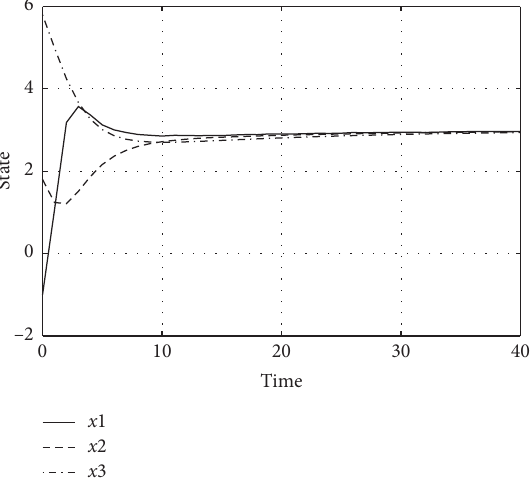
Figure 2: States of agents without communication delay.